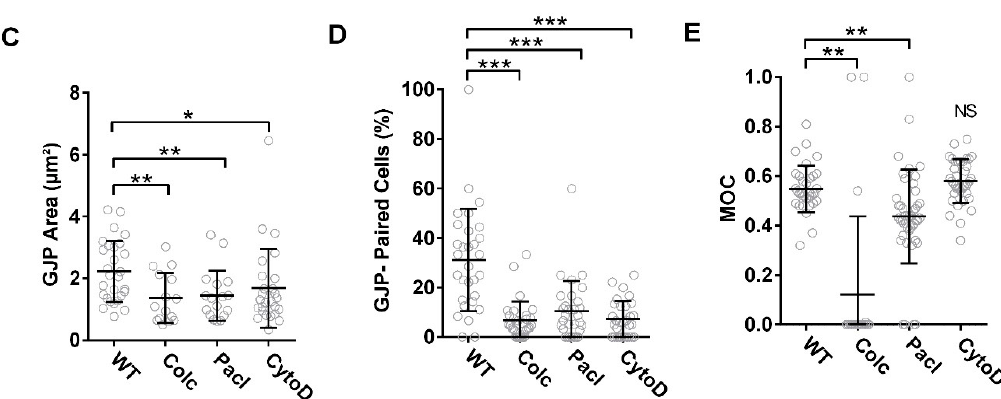
Figure 5. Pharmacological manipulation of the cytoskeletal network inhibits Cx36 recruitment. ( A ) Immunoblot analysis of Neuro-2a cells were transiently transfected to express wild-type Cx36-EGFP and subsequently treated with Colchicine (Colc), Paclitaxel (Pacl), or Cytochalasin D (CytoD). No differences in the expression levels were noted. Cx36 protein was detected using an anti-EGFP antibody, and an anti- β -actin antibody was used to detect actin as the loading control. Protein standard is denoted in kDa. ( B ) Neuro-2a cells were fixed with formaldehyde and mounted onto slides with DAPI containing media 48 h post-transfection. Cx36 proteins are shown in green. Formation of GJPs in vivo under pharmacological manipulation of the tubulin cytoskeleton (Colchicine and Paclitaxel) or the actin cytoskeleton (Cytochalasin D) are shown. Circles indicate GJPs. Scale bar: 10 µm, nuclear DAPI staining in blue. Quantification of GJP area ( C ) and incidences of GJP formation ( D ) revealed severe impairments under all pharmacological treatments tested. Data are mean ± SEM. For GJP area, sample sizes ( n ) were 28 for the WT, n = 15 for Colchicine, n = 17 for Paclitaxel, and n = 26 for Cytochalasin D. For GJP-paired cells, n = 30, where 10 images were collected in 3 independent experiments. * p < 0.05, ** p < 0.001, *** p < 0.0001, Kruskal–Wallis test; all samples were compared to the WT control. ( E ) Co-localization studies were performed between Cx36 and the tubulin cytoskeleton; co-localization was expressed using Mander’s overlap coefficient. Treatment with Colchicine and Paclitaxel reduced Cx36-tubulin co-localization, suggesting tubulin must be intact to support sufficient Cx36 interaction. Treatment with Cytochalasin D had no impact on the co-localization of Cx36 to the tubulin. Data are mean ± SEM. Sample size ( n ) indicated the number of cells measured for tubulin co-localization and were n = 34 for the WT, n = 21 for the Colchicine, n = 45 for Paclitaxel, and n = 38 for Cytochalasin D. ** p < 0.001, Kruskal–Wallis test; all samples were compared to its corresponding WT values.